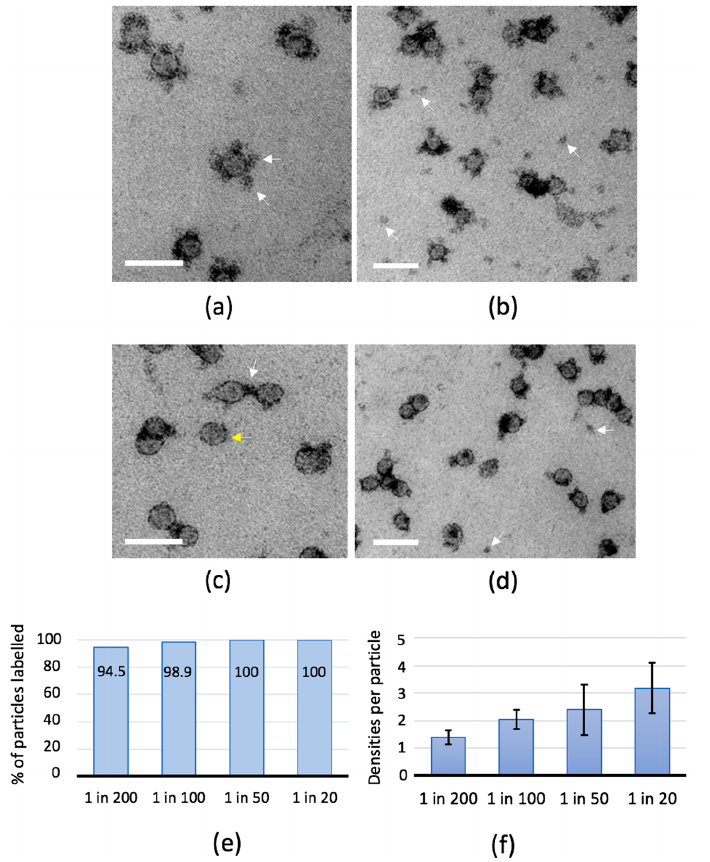
Figure 3. Antibody labelling of purified LDL. LDL adsorbed to support films was labelled using polyclonal antibodies raised against apolipoprotein B (ApoB) and contrasted with mixed metal MC. ( a,b ) 1/20 dilution and ( c,d ) 1/200 dilution. In ( a ) (high-magnification) the antibody densities surround LDL particles (arrows) and, in ( b ) (low-magnification) the particles are surrounded by multiple antibody densities with abundant contrasted features in between, likely representing unbound antibody. In ( c ), some LDL particles have no associated antibody density (yellow arrow) and others appear to have bridges of contrast spanning between the two particles (white arrow). In ( d ) the low-magnification overview shows fewer isolated densities (putative unbound antibody, white arrows) than are seen in ( b ). Scale bars 50 nm. Increasing the concentration of antibody maximizes the percentage of LDL particles that are labeled ( e ) and also increases the number of densities associated with each LP (error bars in ( f ) represent SD; > 100 particles analyzed in each case).